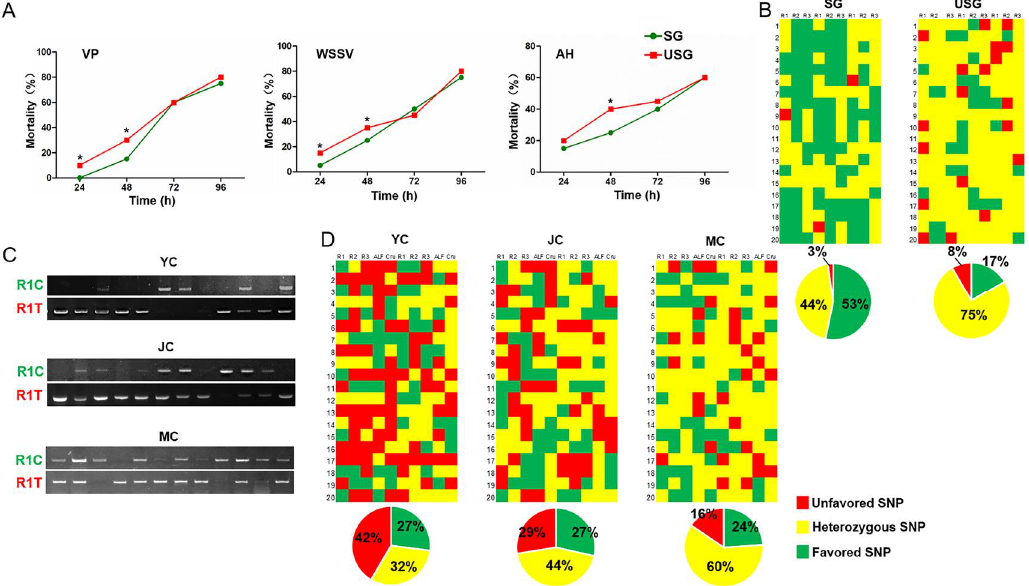
Figure 4. Comparison of disease resistance of mature crayfish between selected group (SG) and unselected group (USG), and genotypes of crayfish population in three growth stages. ( A ) Mortality of mature crayfish challenged with Vibrio parahaemolyticus (VP), Aeromonas hydrophila (AH), and white spot syndrome virus (WSSV). ( B ) Genotype diagram of SG and USG individuals; horizontal (including three individuals per row) and vertical rows of rectangle represent different individuals and R1, R2, R3, ALF, and Cru SNP sites, respectively. ( C ) Electrophoresis gel images of PCR products to detect SNP (R1) genotypes of some young, juvenile, and mature crayfish in the cultured population. ( D ) Genotype diagram of young, juvenile, and mature crayfish in the cultured population; horizontal (including two individuals per row) and vertical rows of rectangle represent different individuals and R1, R2, R3, ALF, and Cru SNP sites, respectively. “*” indicates p < 0.05. To verify that the young and juvenile crayfish with unfavoured genotypes of the three immune genes were eliminated by stress and disease under natural conditions,